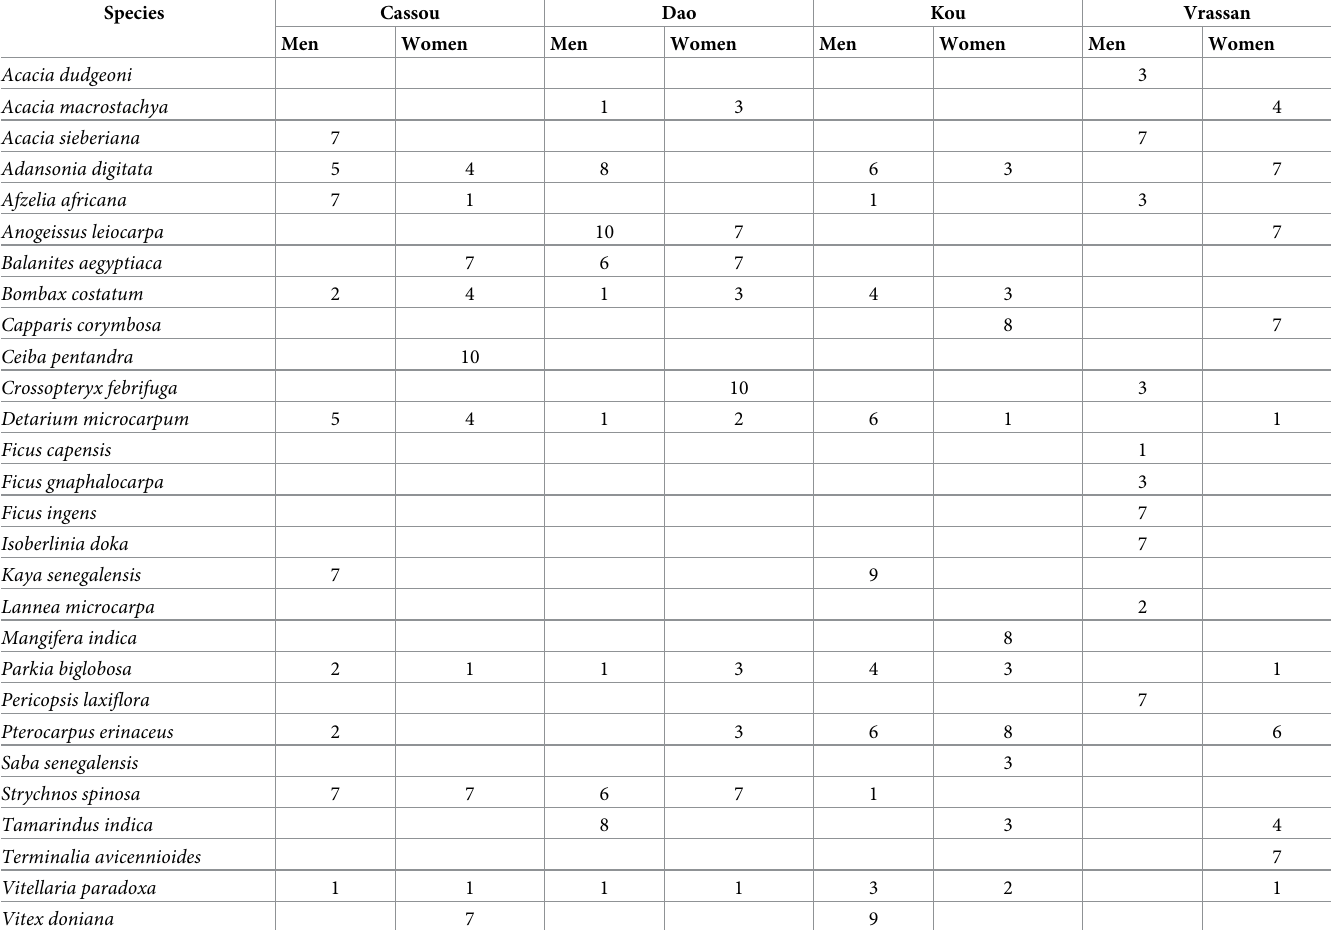
Table 4. Scoring of the preferred tree species according to the gender in each village (Cassou, Dao, Kou and Vrassan) in Ziro province of Burkina